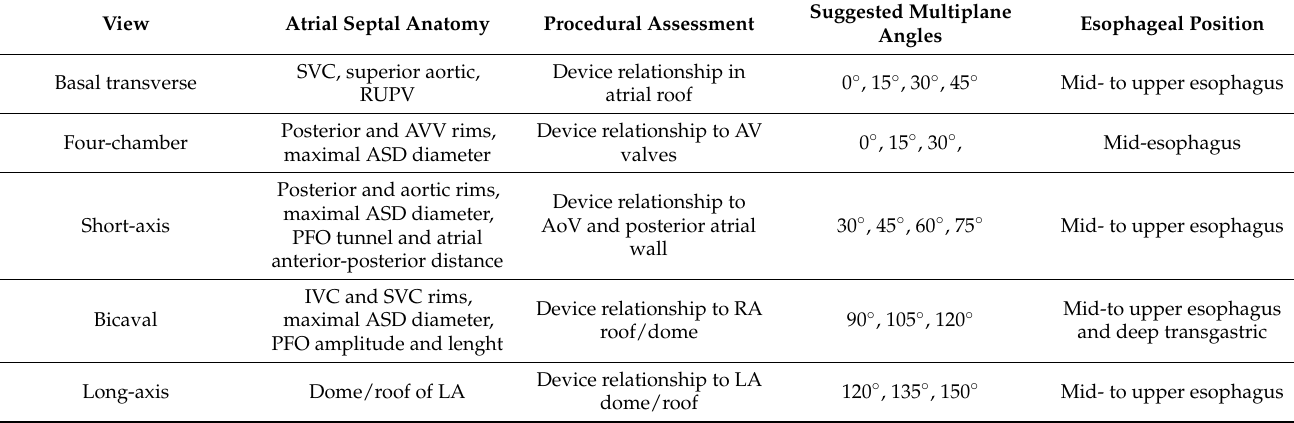
Table 1. Proposed TEE view for ASD/PFO assessment (modified from Silvestry et al. J Am Soc Echocardiogr, 2015) [5].